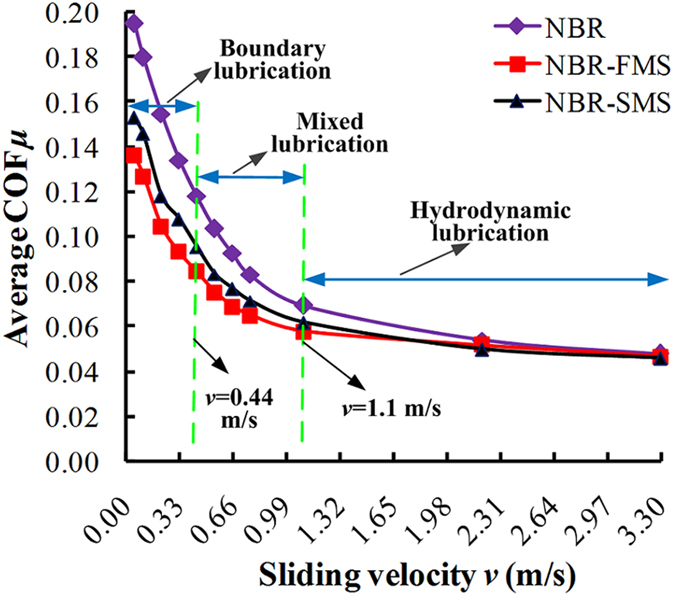
Effect of different MoS2 nanoparticles on the average COFs between the rubber and ZCuSn10Zn2 ring-discs.